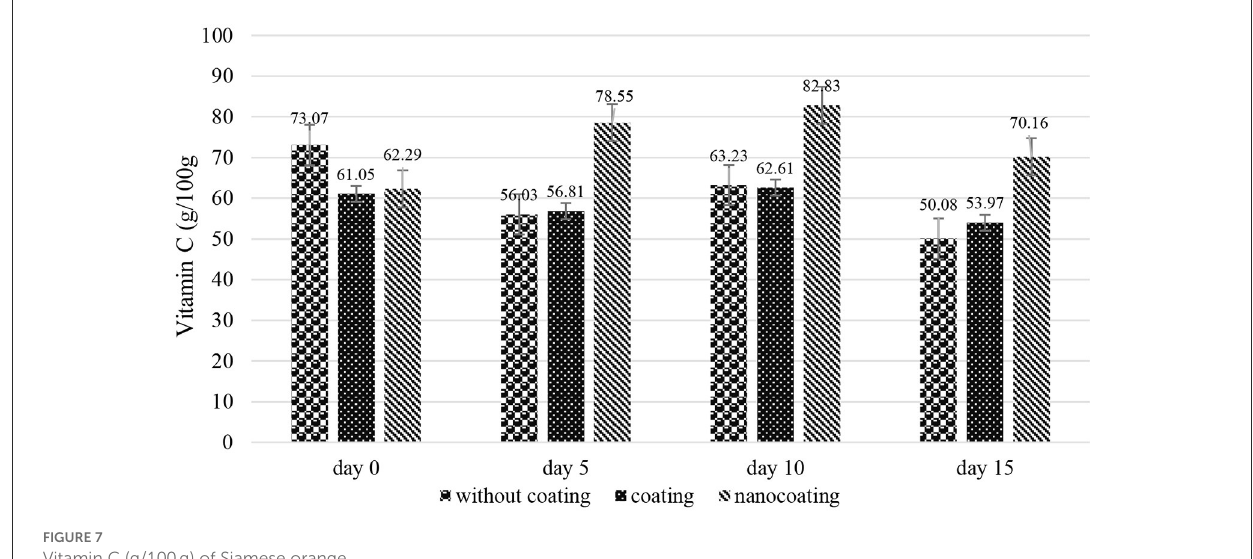
FIGURE7 Vitamin C (g/100g) of Siamese orange.